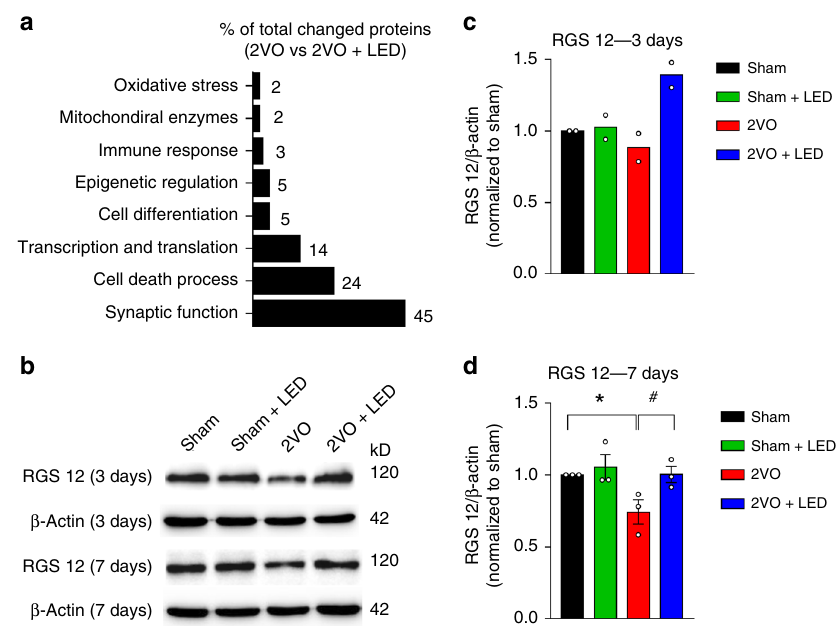
Fig. 7 Pro fi ling hippocampal protein expression associated with 40 Hz light treatment. a GO analysis according to the functions of 31 proteins, which signi fi cantly altered their expression in the 2VO + LED group. b Representative western blots are showing increased levels of RGS12 expression 3 d (4 repeats from n = 2 mice) and 7 d (6 repeats from n = 3 mice) post 2VO. c , d Quanti fi cations of RGS12 expression using β -actin as an internal standard of 3 d ( n = 2 mice in each group) and 7 d ( n = 3 mice in each group) post 2VO groups, respectively. Data represent the mean ± SEM. Error bars indicate SEM. * is for comparison between Sham and 2VO groups; # is for comparison between 2VO and 2VO + LED groups. *, # P < 0.05. The test used in d 2ANOVA with LSD ’ s post hoc test. Source data are provided as a Source Data fi